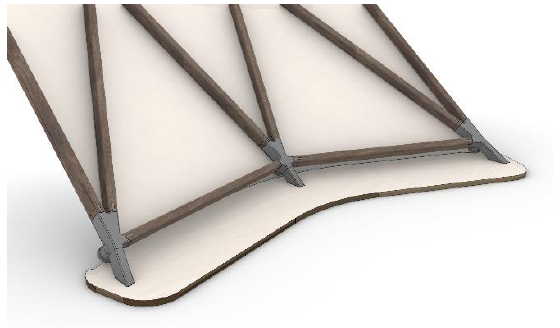
Figure 12. Fixation at the plywood plate which are fixed at the bottom.